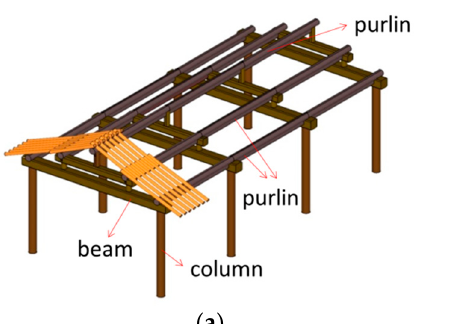
Figure 1. Traditional four-beam and eight-column village residence: ( a ) the four-beam and eight-column timber frame and ( b ) the timber frame with masonry infill wall.